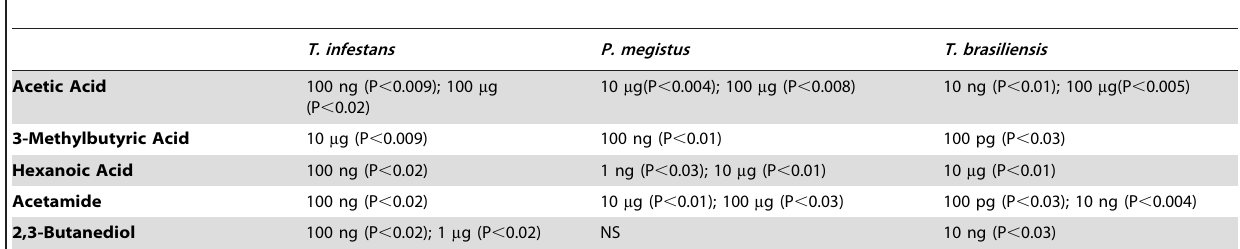
Table 1. Doses of acetamide, 2,3-butanediol, acetic acid, 3-methylbutyric acid and hexanoic acid significantly attractive for T. infestans , P. megistus and T. brasiliensis